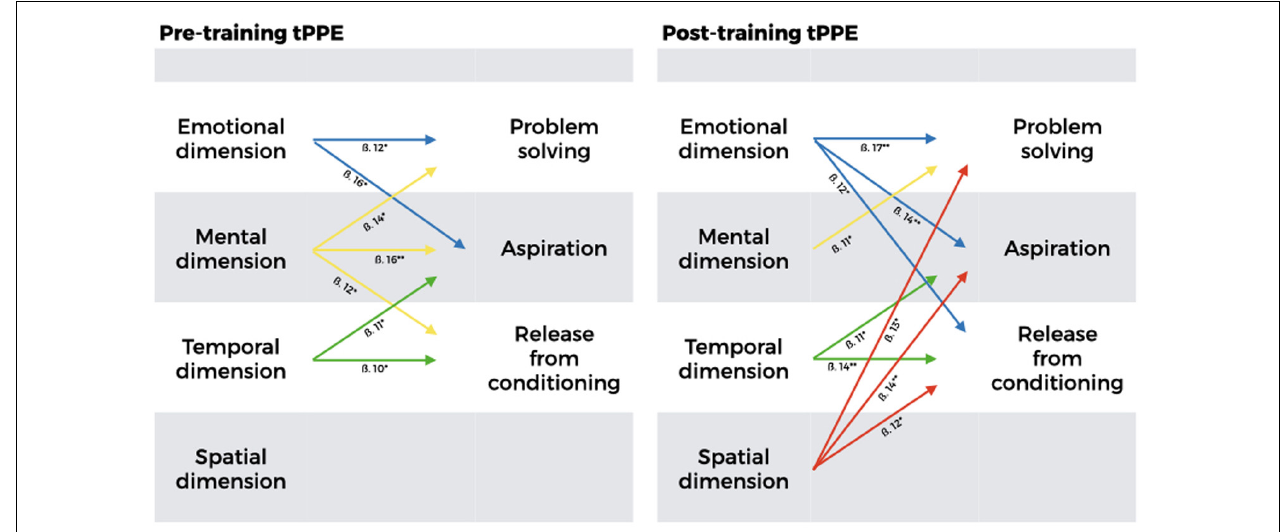
FIGURE 2 | Graphic representation of multiple linear regression models (dependent variables: self-determination; independent variables: emotional, mental, spatial, and temporal dimensions). PPEt, technique of the Place of Pre-Existence. * p ≤ 0.05, ** p ≤ 0.01. See Tables 2A,B for further details. Note that while the temporal dimension remained the same, the spatial dimension only appeared after